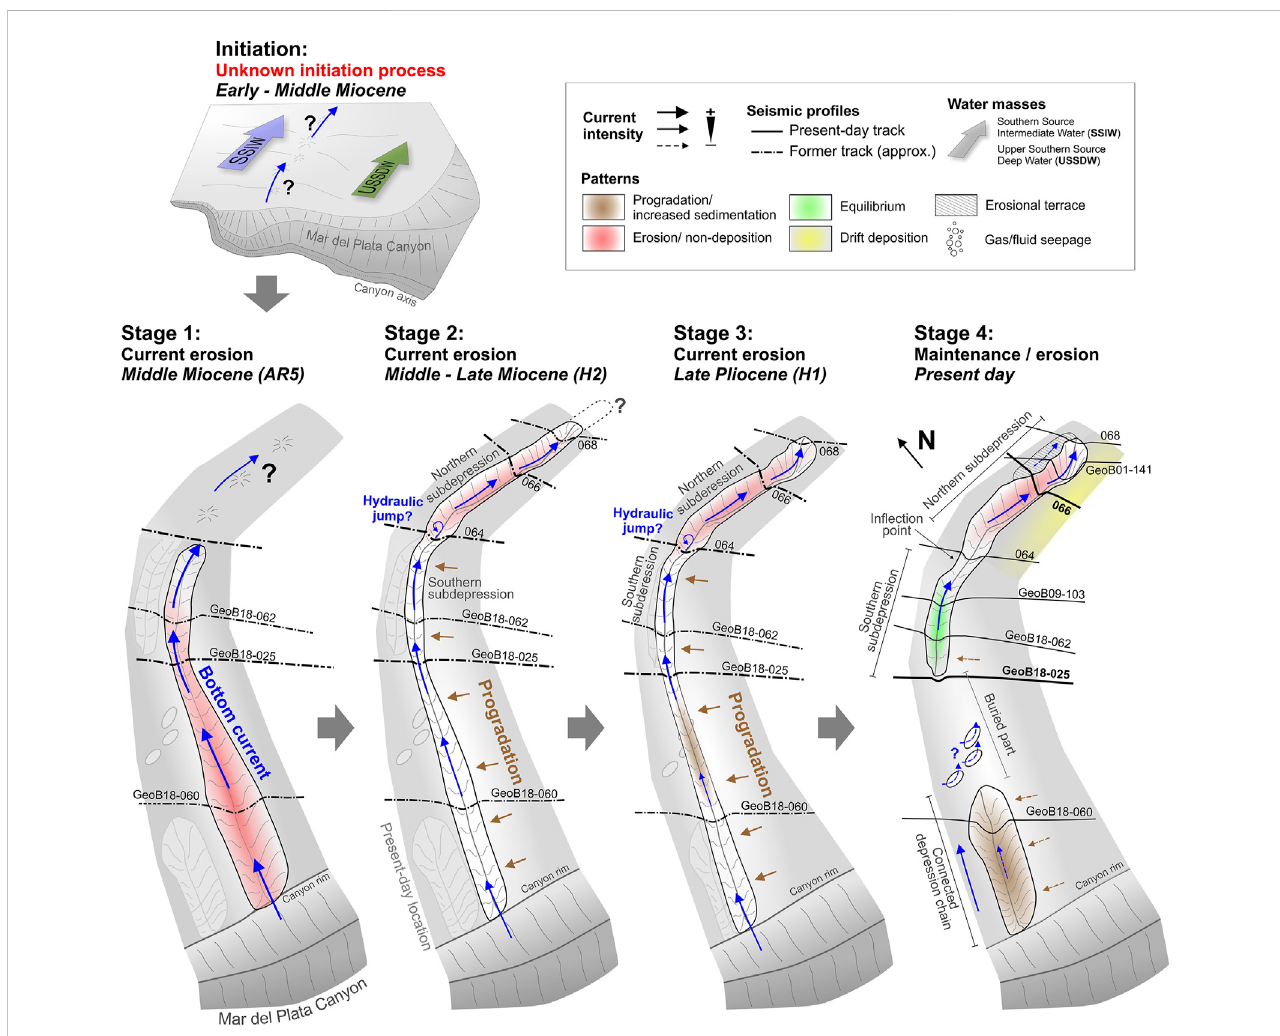
FIGURE 11 Conceptual model showing the proposed development of SD-N (Stage 1 – 4). For potential initiation processes (Section 5.4.1) and a detailed description of the evolutionary stages (Section 5.4.2), please refer to the